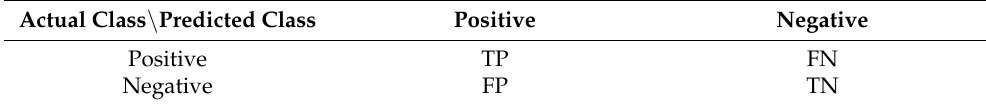
Table 3. Confusion